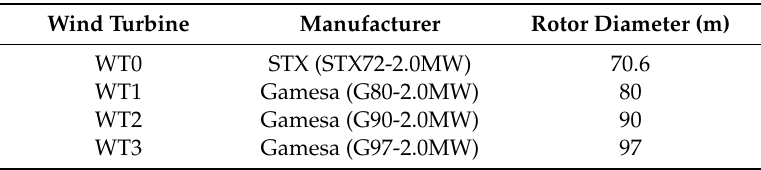
Table 2. Wind turbines considered in this